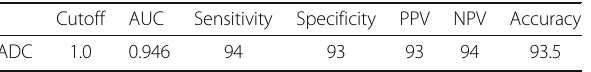
Table 5 A threshold ADC value for differentiating malignant from benign lesions and the statistical data obtained Cutoff